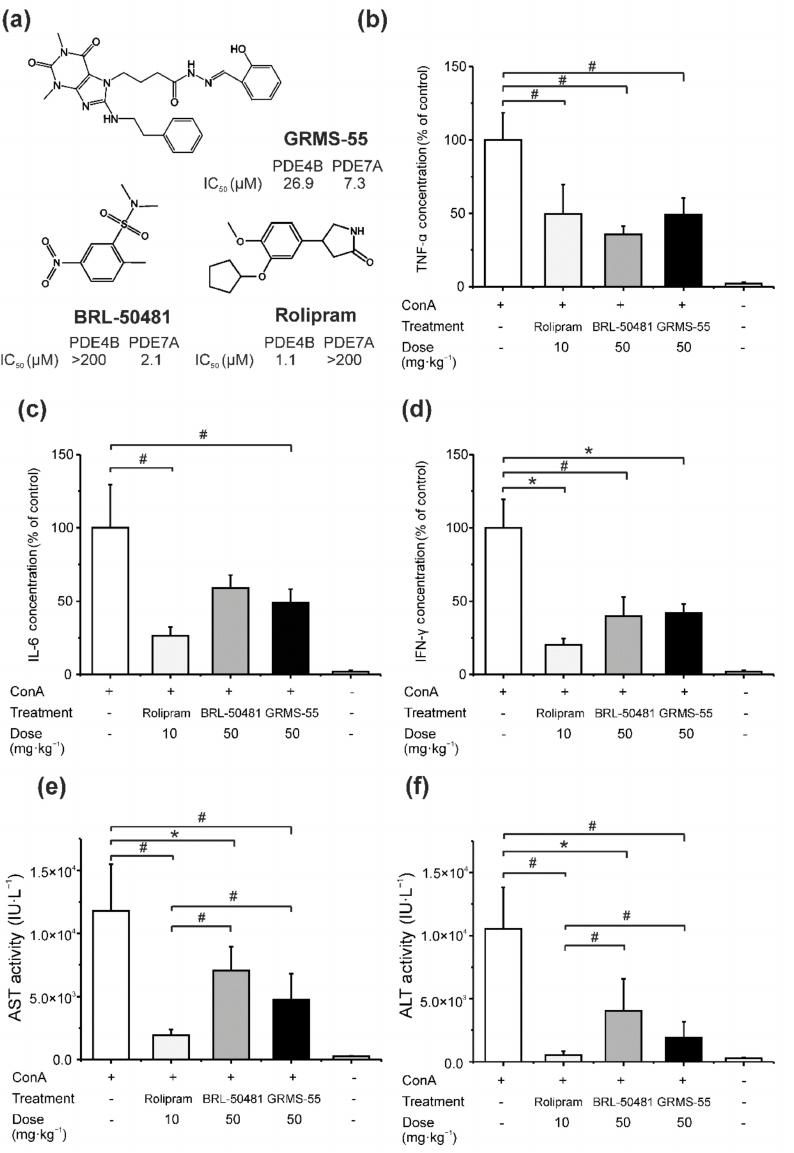
Figure 2. Preliminary pharmacological evaluation of the studied PDE inhibitors in ConA-induced hepatitis. ( a ) Chemical structures of the studied compounds and their IC 50 values for PDE4B and PDE7A determined in an in vitro assay in our previous work [11]; ( b – f ) Effects of the compounds on the levels of inflammatory mediators and transaminases in the serum of mice with ConA-induced hepatitis. Rolipram (10 mg · kg − 1 ), BRL-50481 (50 mg · kg − 1 ), and GRMS-55 (50 mg · kg − 1 ) were administered IP in BALB/c mice 30 min before ConA administration at an IV dose of 20 mg · kg − 1 . Bars represent the mean (+SD) concentrations of ( b ) TNF- α , ( c ) IL-6, and ( d ) IFN- γ and activities of ( e ) AST and ( f ) ALT expressed as % of negative control in the mice serum 8 h following ConA administration ( n = 6). The negative control group received ConA and vehicle instead of the studied compounds and the healthy control (the last bar in each graph) received saline and vehicle instead of ConA and studied compounds. * p < 0.05, # p < 0.01, a one-way ANOVA with Tukey’s HSD post-hoc